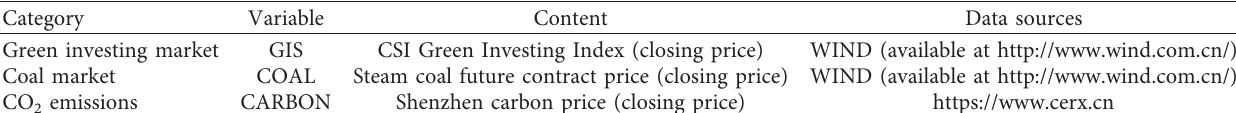
Table 2: Variable description.